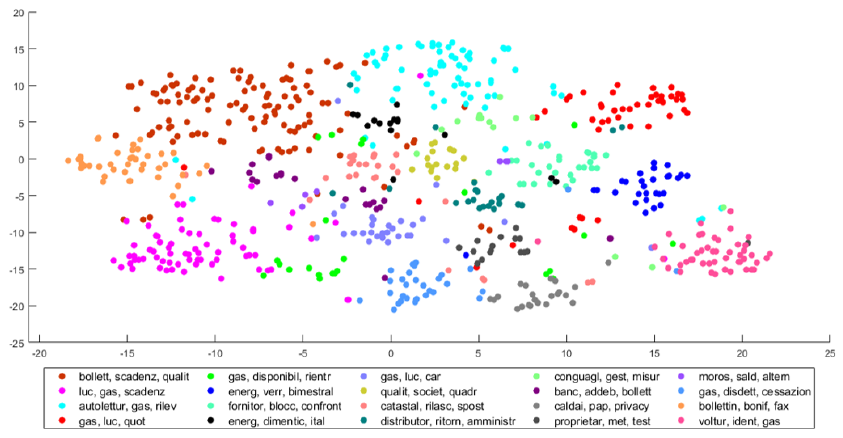
Figure 8. t-SNE representation of 2D